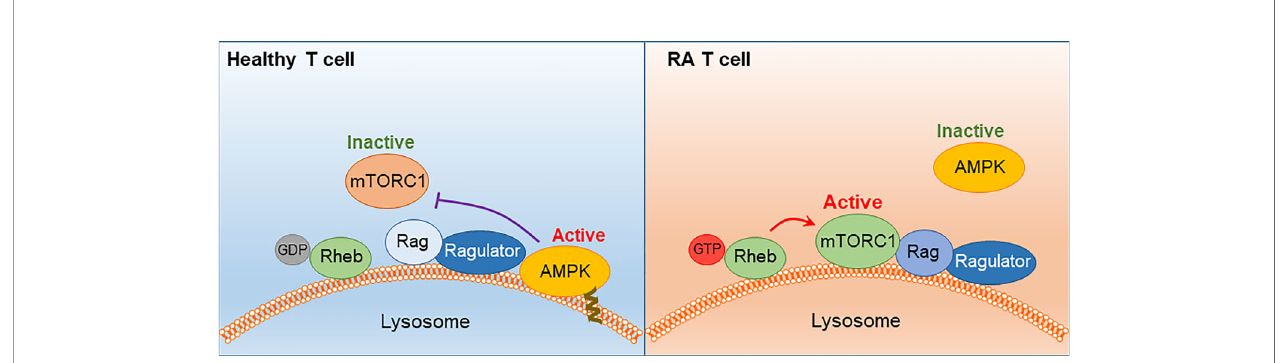
FIGURE 6 | AMPK signaling failure and unopposed mTORC1 activation in RA T cells. In healthy T cells, AMPK senses the cell ’ s energy state by traf fi cking to the lysosomal surface, where it is anchored in the lysosomal membrane through a myristoylated tail. AMPK interacts with the Ragulator-Rag complex, resulting in dissociation and inactivation of mTORC1. In RA T cells, a defect in protein myristoylation leads to mistraf fi cking and cytosolic retention of AMPK. mTORC1 is retained at the lysosomal surface, where Rheb-GDP converts into Rheb-GTP and switches on the kinase activity of mTORC1. mTORC1 activation persists in RA T cells despite low